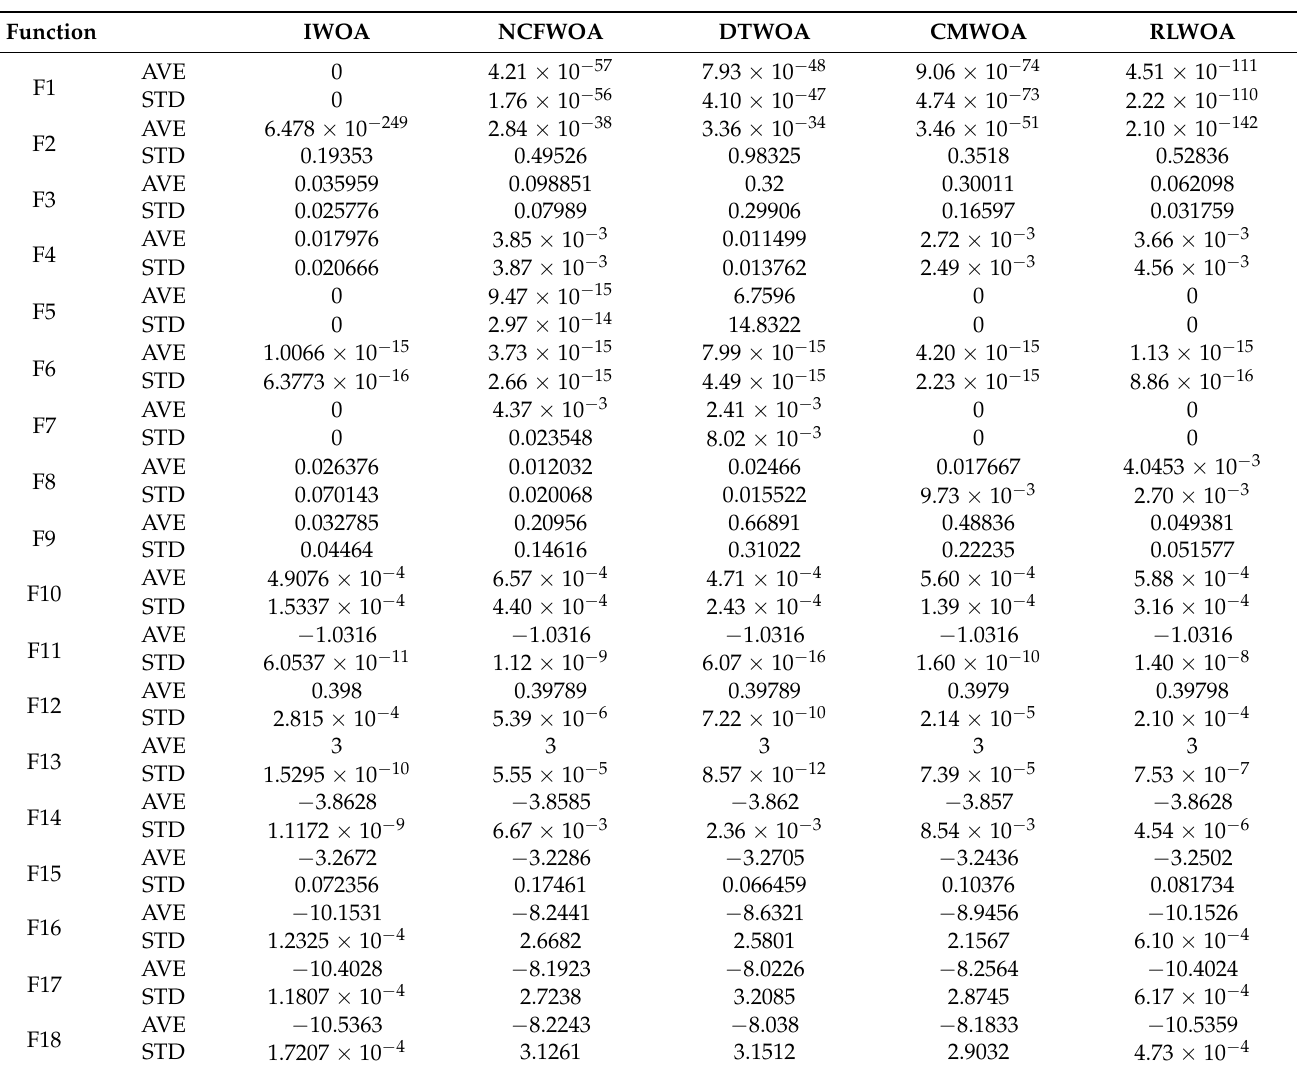
Table 4. Influence of different improvement strategies on WOA